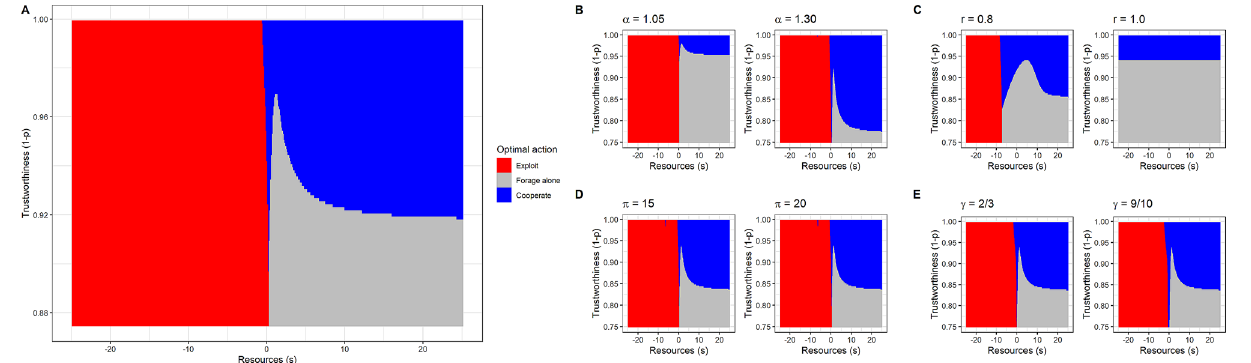
Figure 1. Optimal actions as a function of the individual’s current resources s and the trustworthiness of the surrounding population, 1 − p . ( A ) All parameters at their default values. This includes: α = 1.2, r = 0.1, π = 10, and γ = 1/3 (see Table 1 for a full list). ( B ) Effect of altering the efficiency of cooperation α to be either lower (1.05) or higher (1.30) than ( A ). Other parameter values are as for ( A ). ( C ) Effects of varying social mobility, to be either high (r = 0.8), or complete (r = 1.0; i.e. resource levels in this time period have no continuity at all into the next). Other parameter values are as for ( A ). ( D ) Effect of increasing the severity of punishment